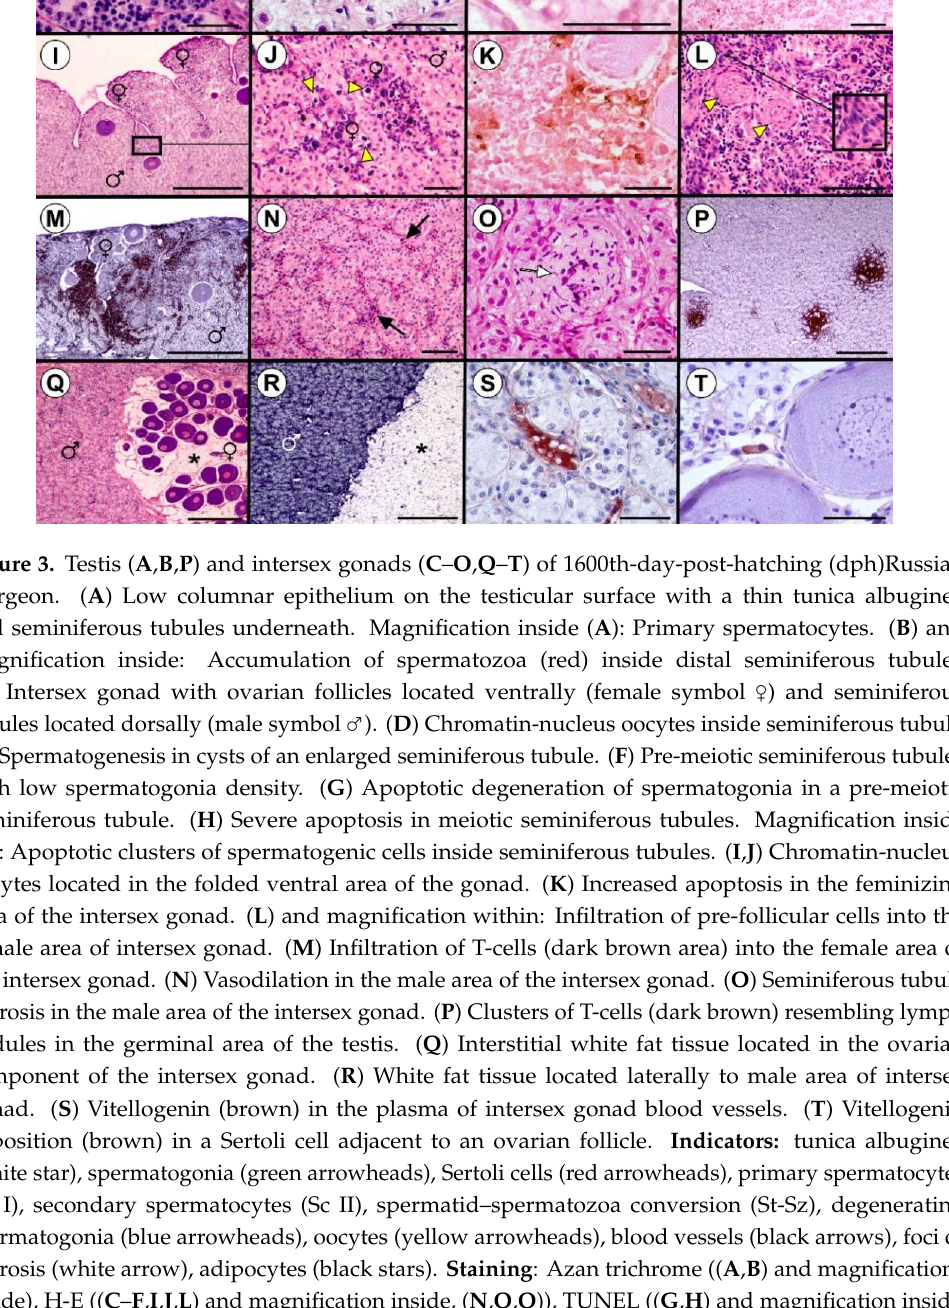
inside), H-E (( C – F , I , J , L ) and magnification inside, ( N , O , Q )), TUNEL (( G , H ) and magnification inside,